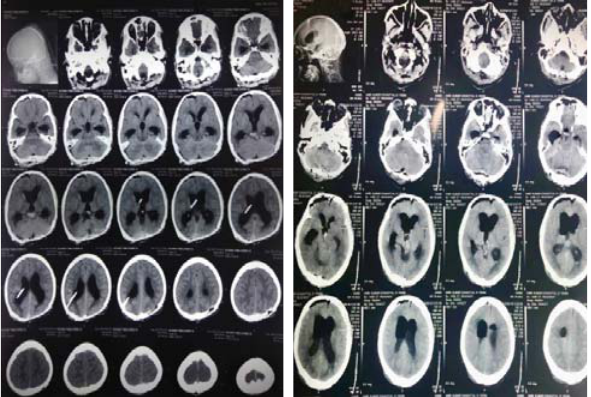
Figure 8. Post-operative CT Scan showing total excision of the tumor with pneumocephalus and